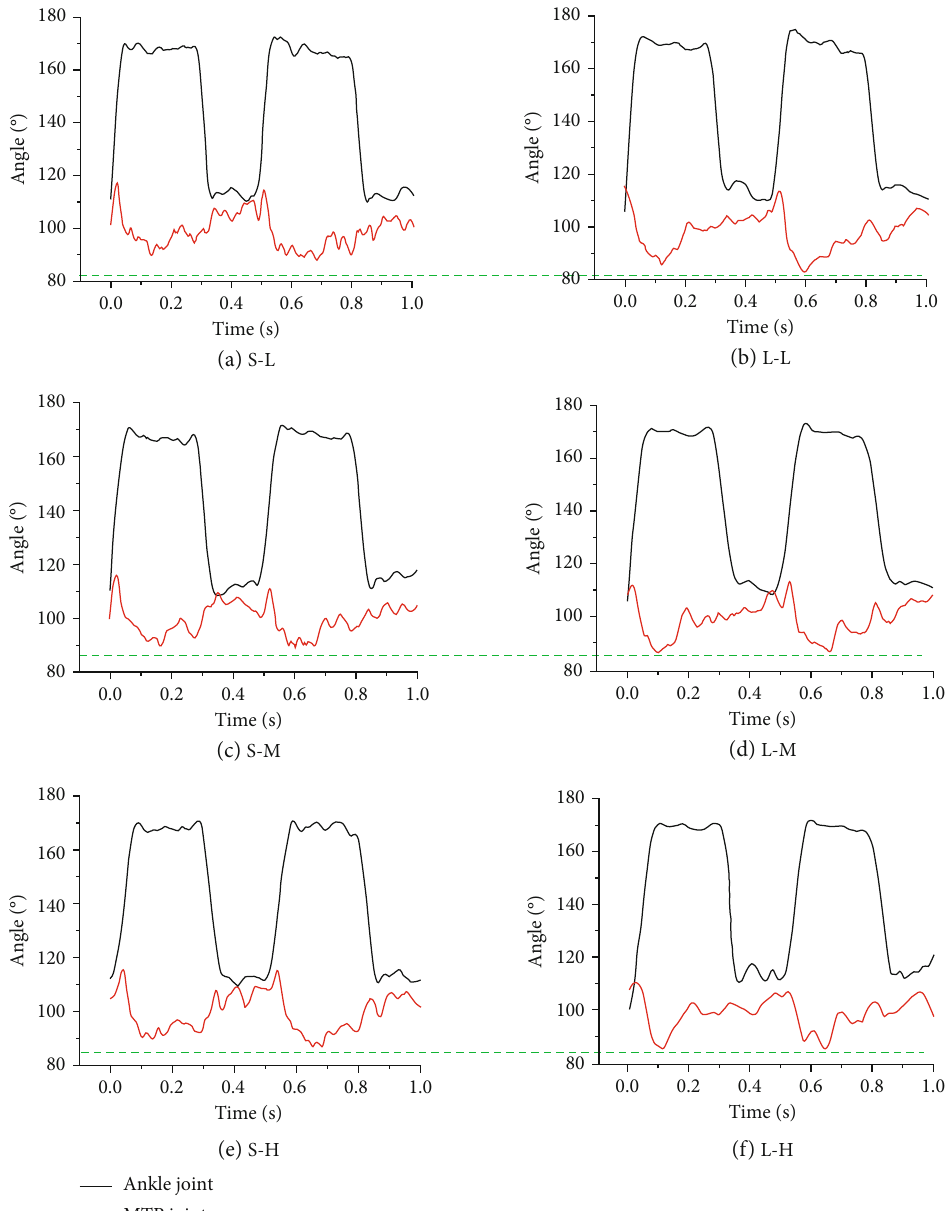
Figure 8: The angle changes curve of the ankle joint and the MTP joint. (a – f) The angle changes of each joint under six working